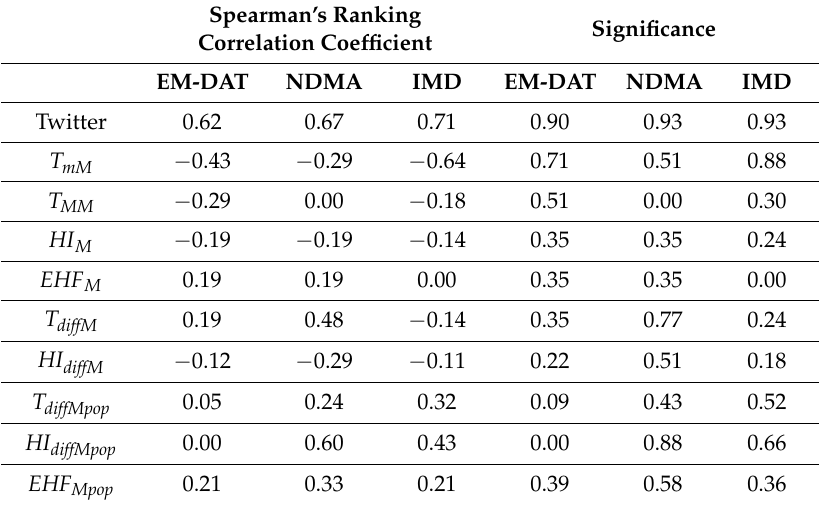
Table 5. Spearman’s ranking correlation coefficient between mortality data according to the three available mortality databases and the considered Twitter and climatic heat wave indicators, together with their